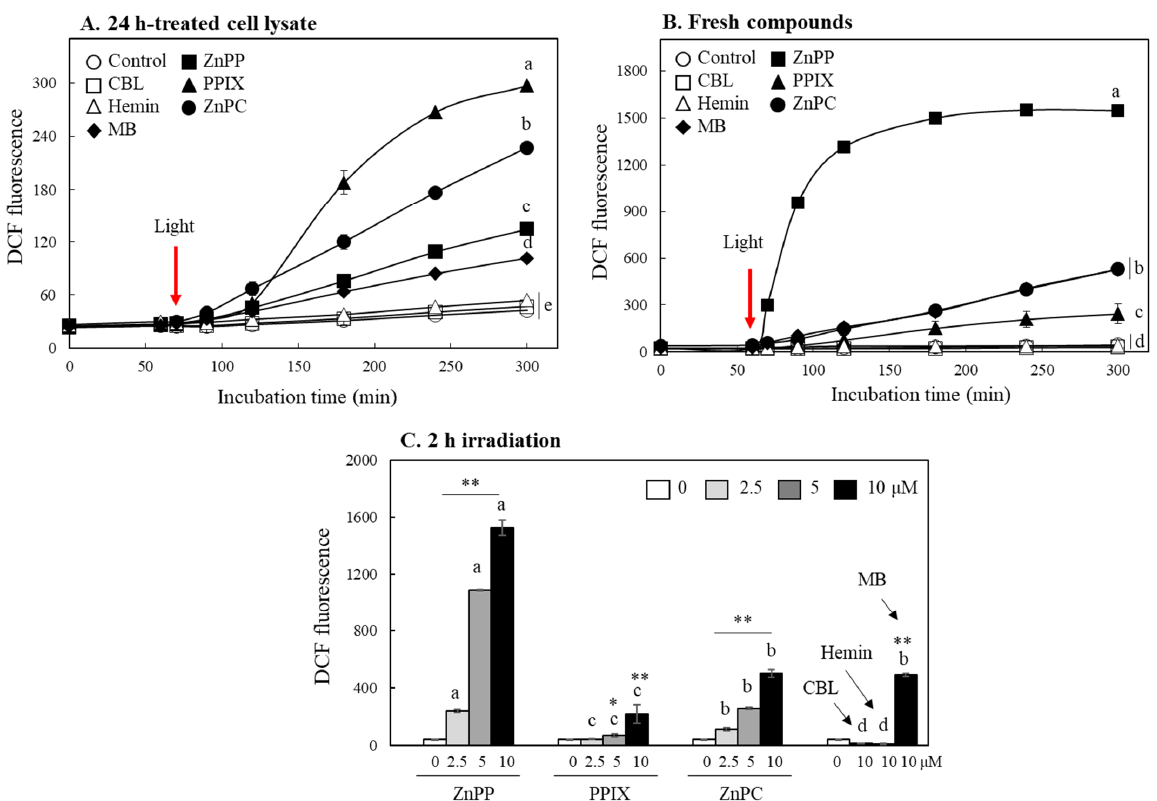
Figure 6. Evaluation of ROS generation property of different porphyrin derivatives under light using DCFH. DCFH prepared from DCFH-DA as described in materials and methods was mixed with INT 407 cell lysates treated with each porphyrin or MB (10 μ M) for 24 h ( A ) or fresh compounds (each 5 μ M) ( B ). The mixture was incubated in a dark for 60 min followed by a light condition, and changes in DCF fluorescence were analyzed during 6 h. Effects of different concentrations of porphyrins on DCF fluorescence changes during 2 h under light were also monitored ( C ). Each value represents the mean ± SD ( n = 3). *, ** Significantly different from control according to Student’s t ‐test (*, p < 0.05; **, p < 0.01). Different letters indicate a significant difference among different porphyrins ( A , B ) or samples within same concentration ( C ) ( p < 0.05) based on one way ANOVA and the Tukey’s HSD test.